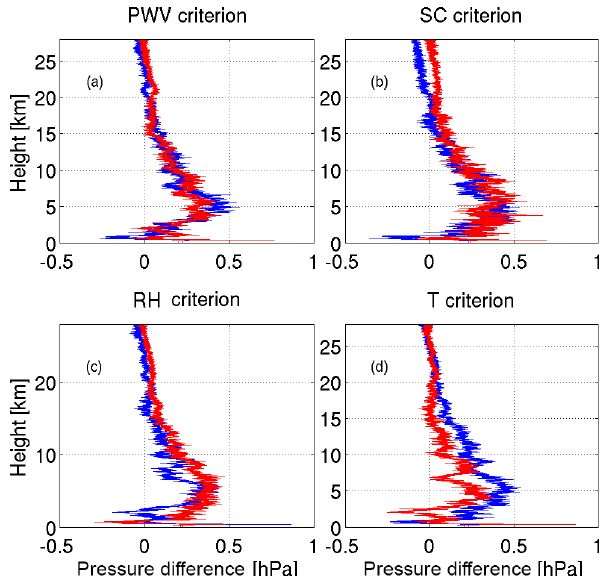
Figure 15. Same as Fig. 14 but for pressure differences.